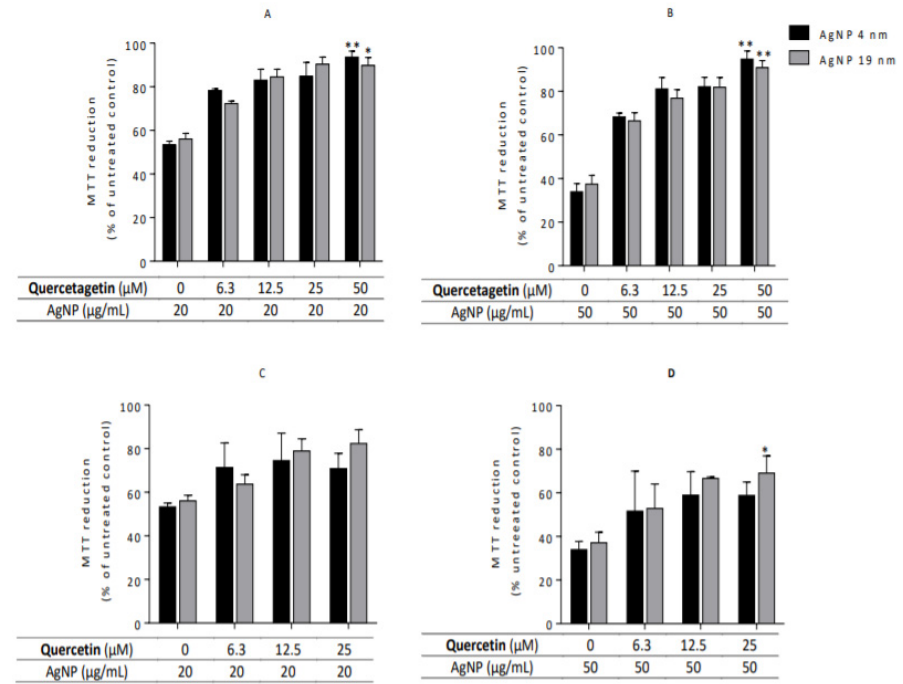
Figure 9. Effect of flavonoid concentration on AgNP-induced cytotoxicity in Caco-2 cells. After 24h co-incubation with cytotoxic AgNP concentrations and non-toxic flavonoid concentrations, cell viability was determined by MTT assay. Cells were incubated with 20 µg/mL AgNP [Subfigures ( A ) and ( C )] and 50 µg/mL AgNP [Subfigures ( B ) and ( D )]. MTT reduction percentages are normalized to untreated cells (100% MTT reduction). * p < 0.05, ** p < 0.01 and *** p < 0.001 when compared with AgNP-treated cells (no flavonoids). Values are presented as the mean ± SEM ( n ≥ 3).